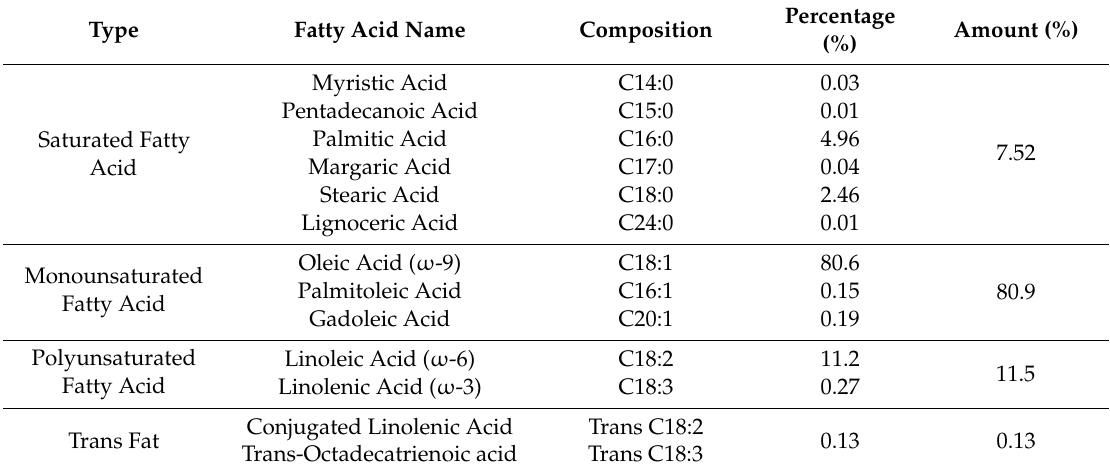
Table 1. Fatty acid composition of hazelnut